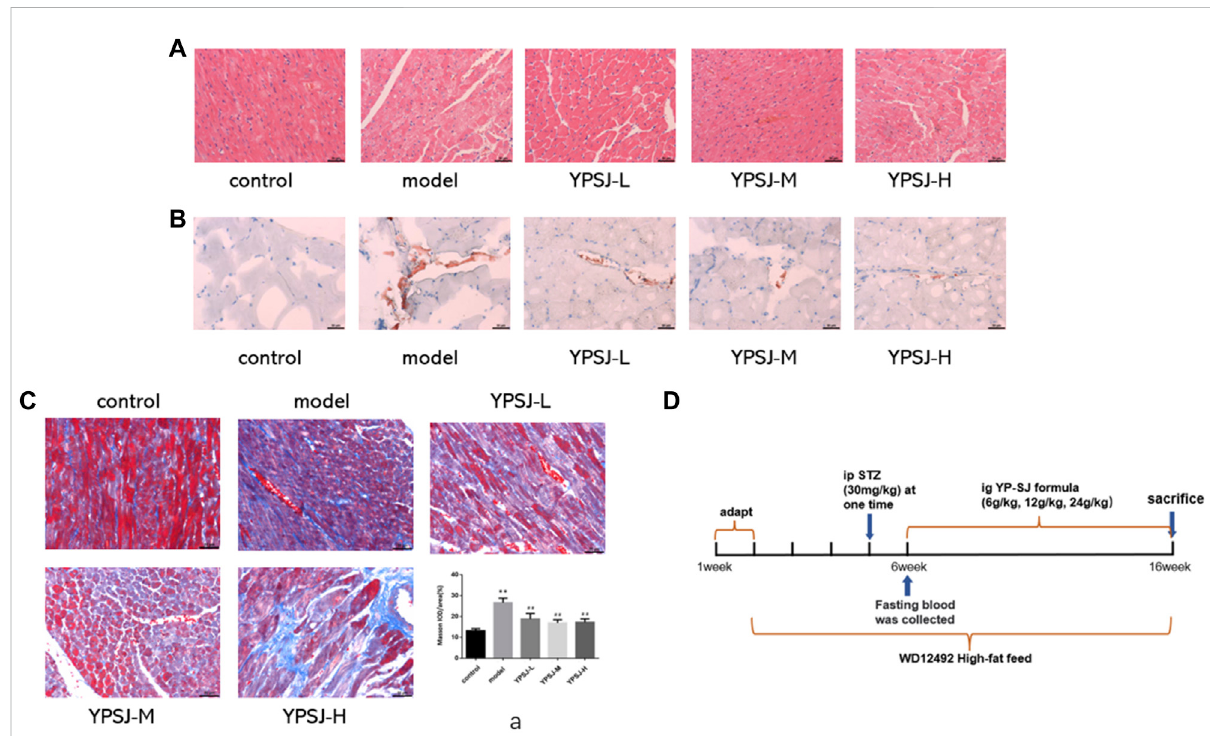
FIGURE 2 The effect of Yunpi-Huoxue-Sanjie (YP-SJ) formula on the rat myocardium.Myocardial specimens (n = 5) were collected and stained with H&E (×200) (A) ; The effect of YP-SJ formula on myocardial lipid accumulation in rats in each group. Myocardial specimens (n = 5) were collected and stainedwithOilredOstaining(×200) (B) ;TheeffectofYP-SJformulaonmyocardial fi brosisinratsofeachgroup.Myocardialspecimens(n=5)were collected and stained with Masson staining (×200) (C) ; Animal experiment time chart (D) ; ** p < 0.01 vs. control group; ## p < 0.05 vs. model group